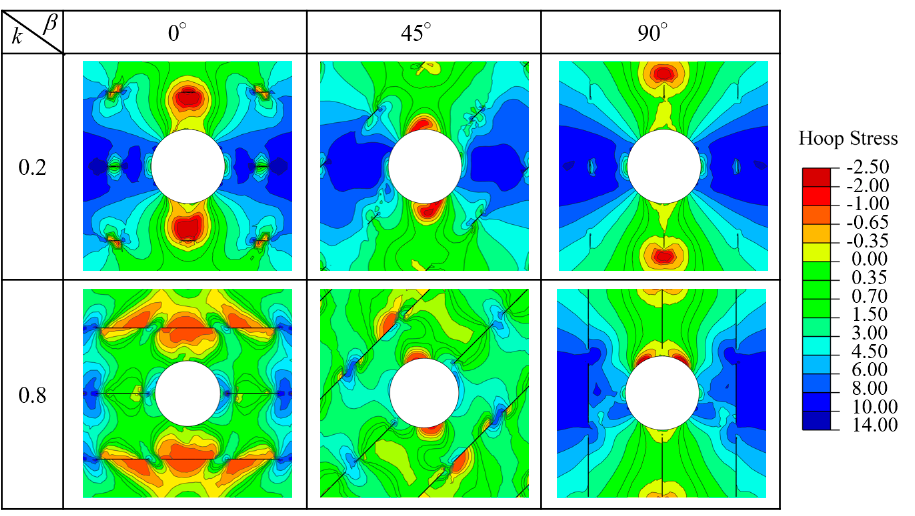
Figure 25. Hoop stress distribution at σ 1 = σ p in the specimens with k = 0.2 and 0.8 at β = 0°, 45°, and 90°.